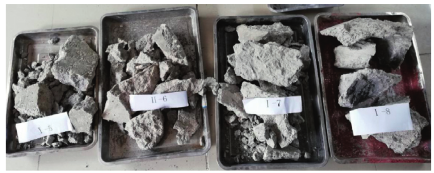
Figure 10: Blasting fragments.